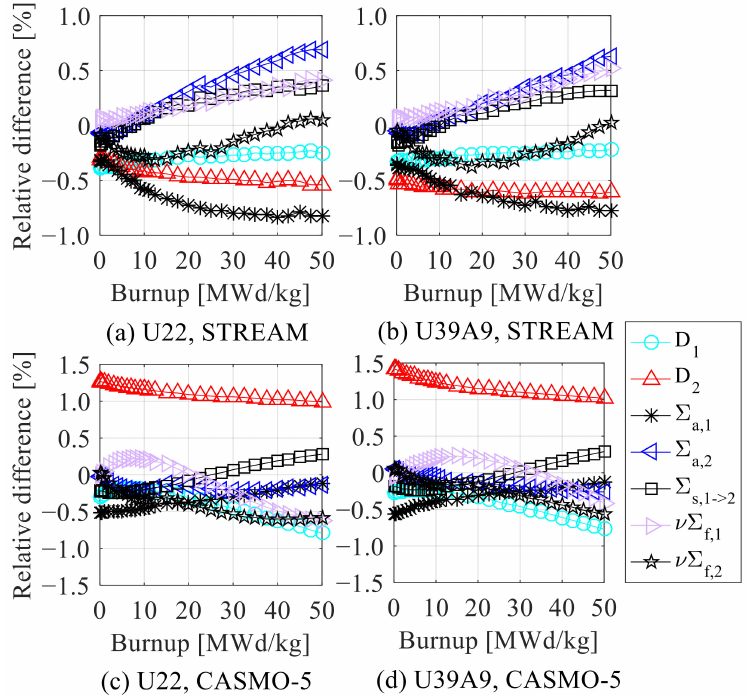
Figure 15. STREAM few-group constants compared with Serpent 2 and